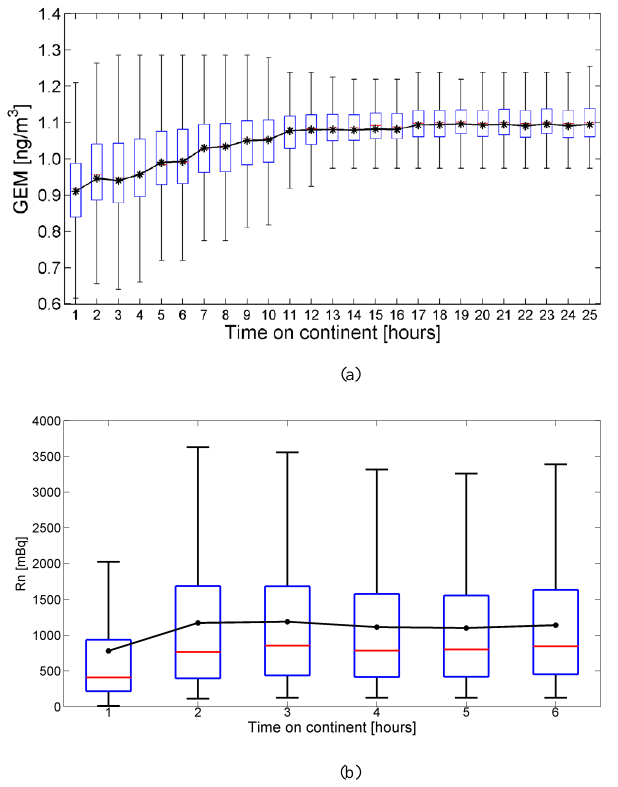
Figure 6. (a) The statistical distribution of GEM concentrations as a function of time spent over the continent and (b) 222 Rn distribution as a function time air masses spent over the continent. The mean is indicated by the black stars, the median by the red line, the 25- and 50 percentile by the blue box and the whiskers indicating 99.3% data coverage (if a normal distribution is assumed), while the black line connects the mean values to provide an indication of the trend observed.